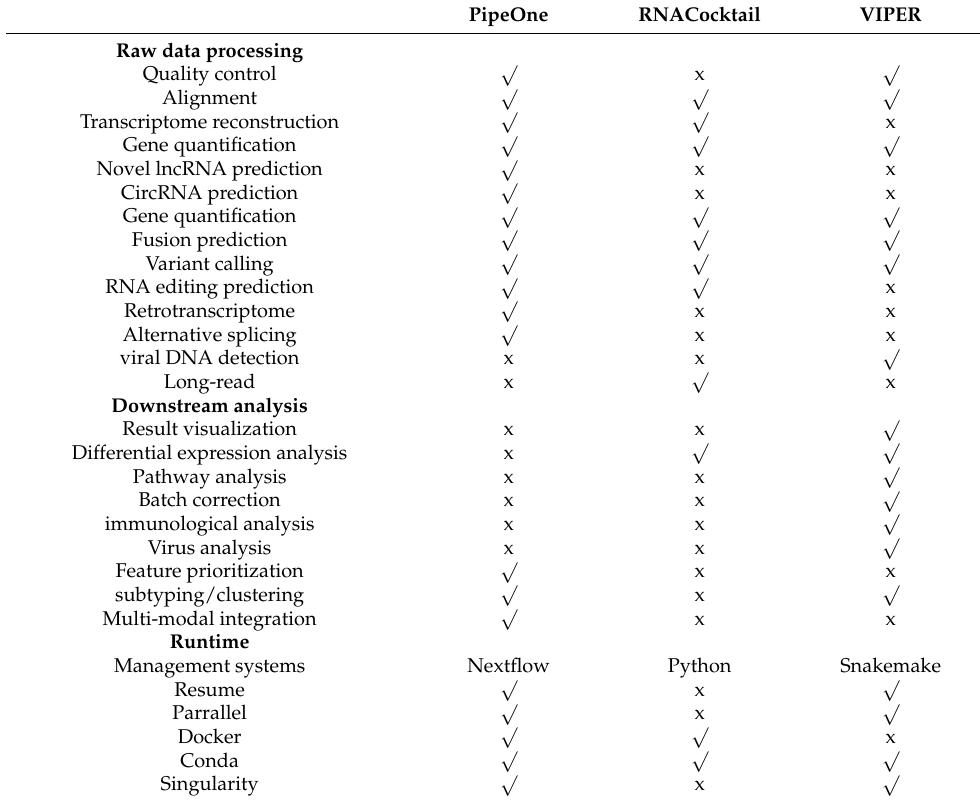
Table 1. Comparing PipeOne with two other pipelines, RNACocktail and